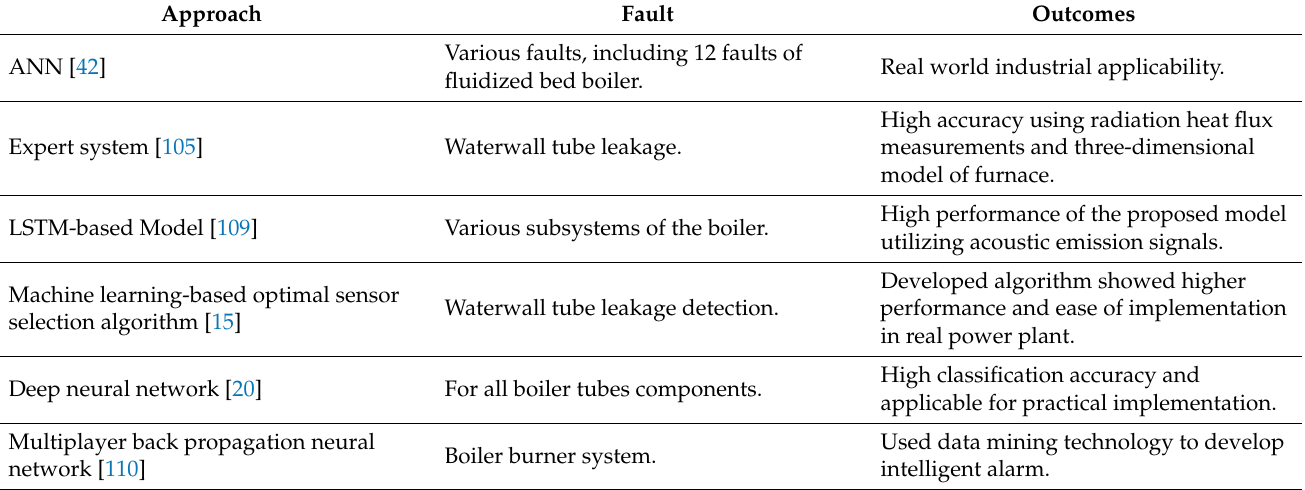
Table 5. Comparison of Different Data-Driven Algorithms for Boiler Tube Leak Detection.